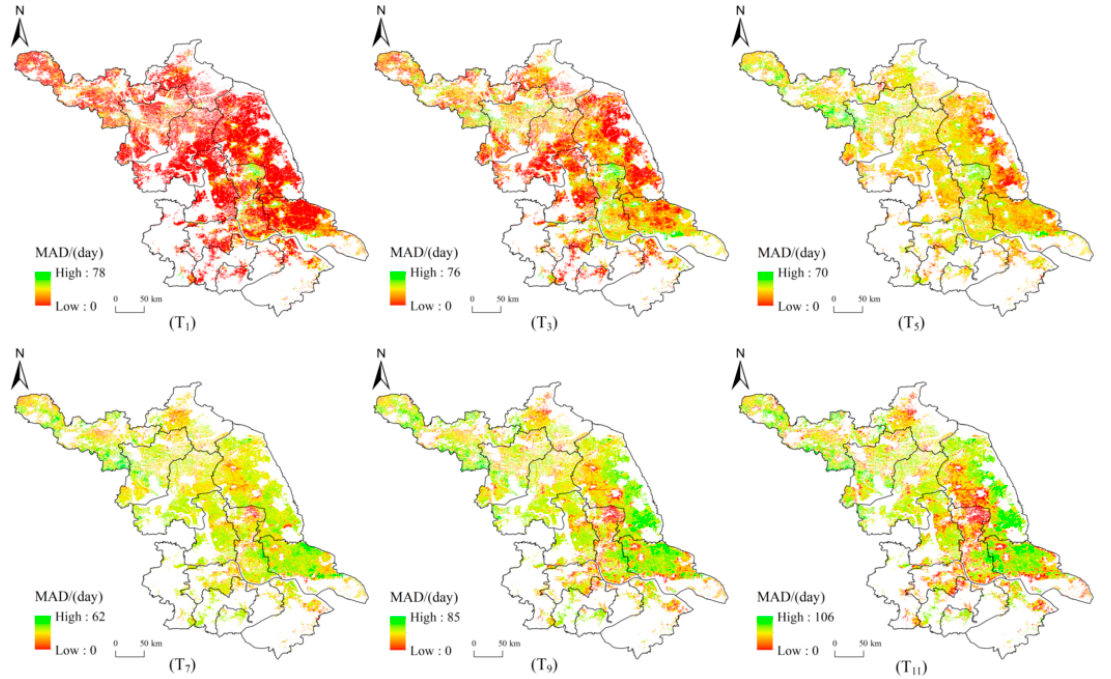
Figure 7. Spatial distribution of the first crop MAD during a double season. Partial results (T1, T3, T5, T7, T9, and T11) are shown. T1: 2001–2007; T2: 2002–2008; T3: 2003–2009; ... ; T11: 2011–2017.